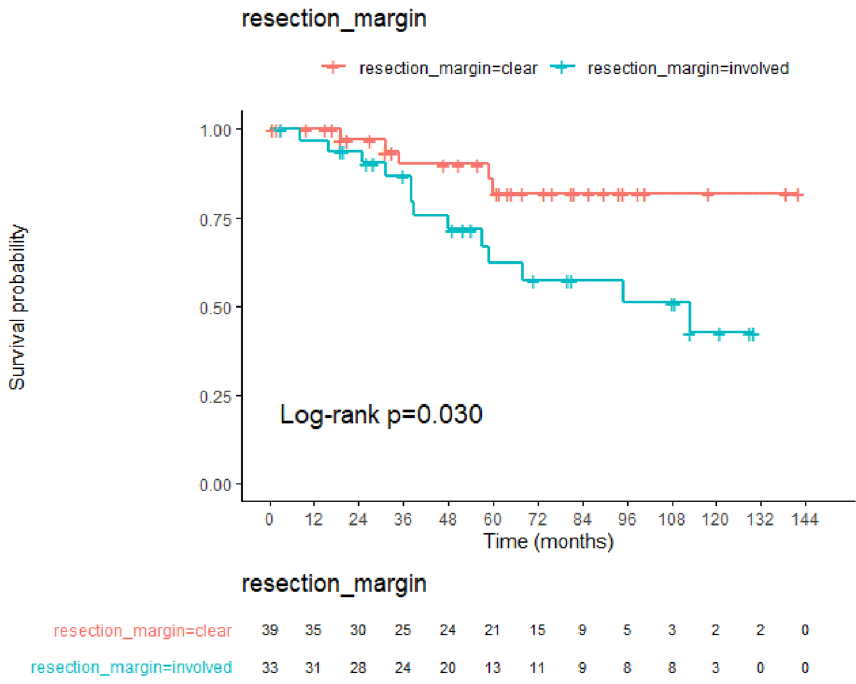
Figure 1. A Kaplan–Meier survival curve showing the overall recurrence-free survival of patients with a resection-margin